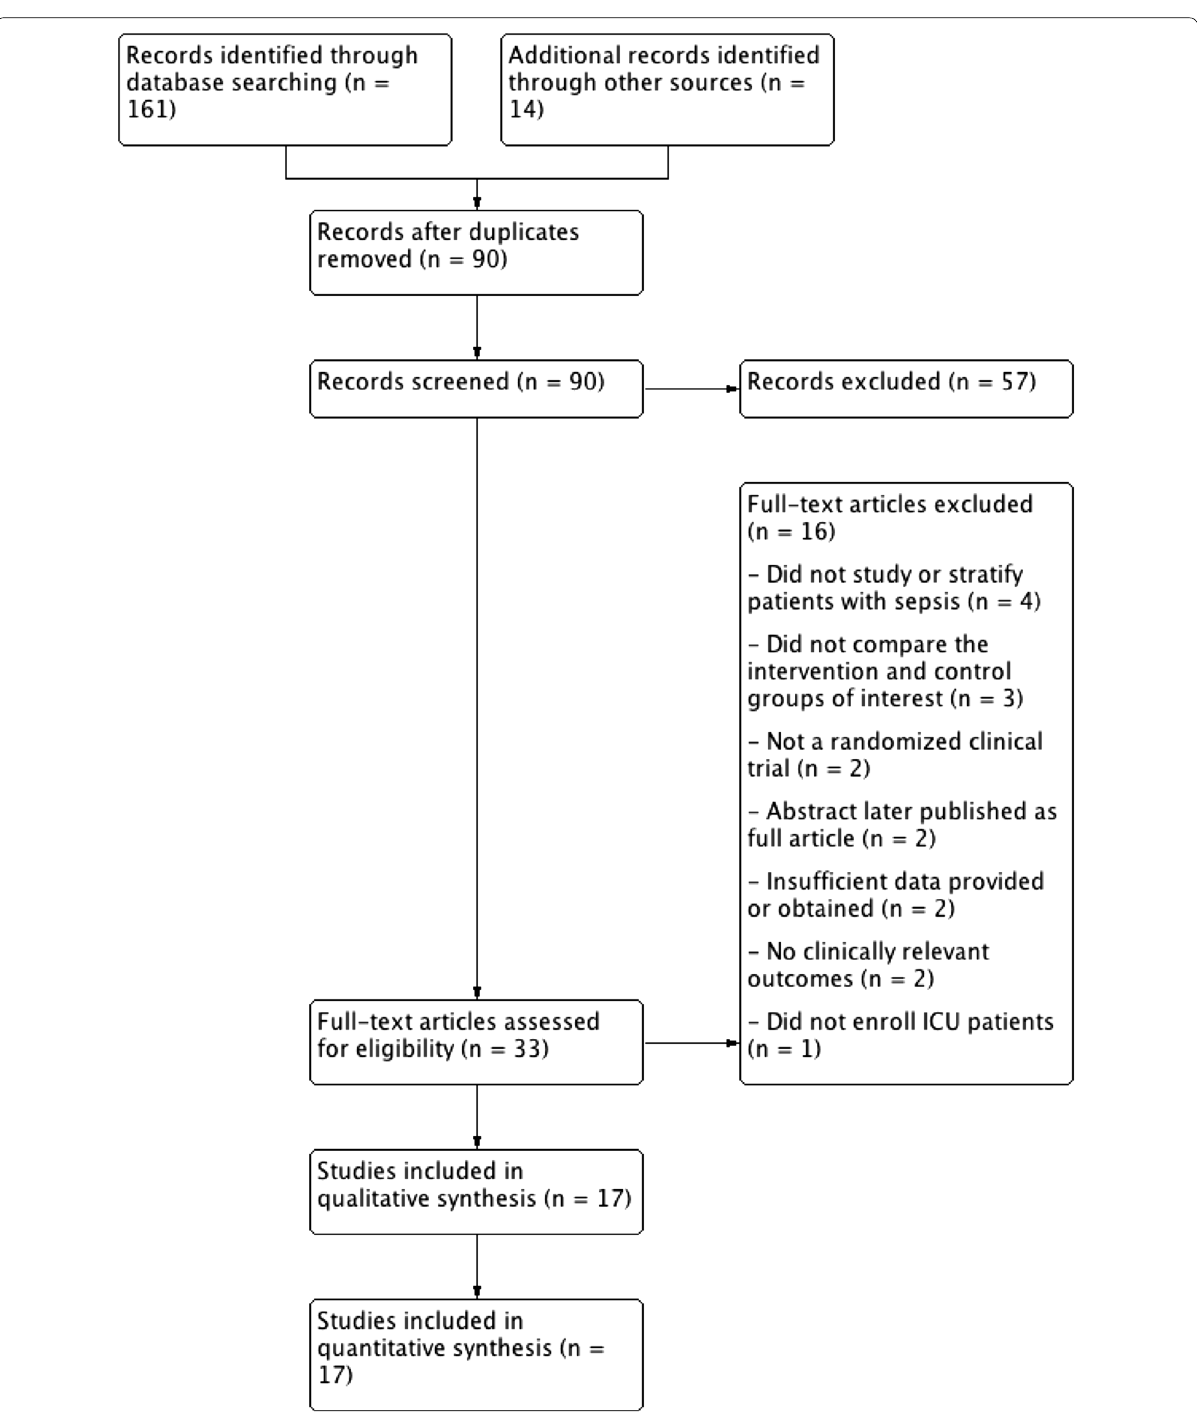
Fig. 1 Preferred Reporting Items for Systematic Reviews and Meta-Analyses (PRISMA) flow chart: description of the study selection process. Seven- teen trials (1 abstract and 16 fully published trials) were eligible and included in the qualitative and quantitative analyses. ICU , intensive care